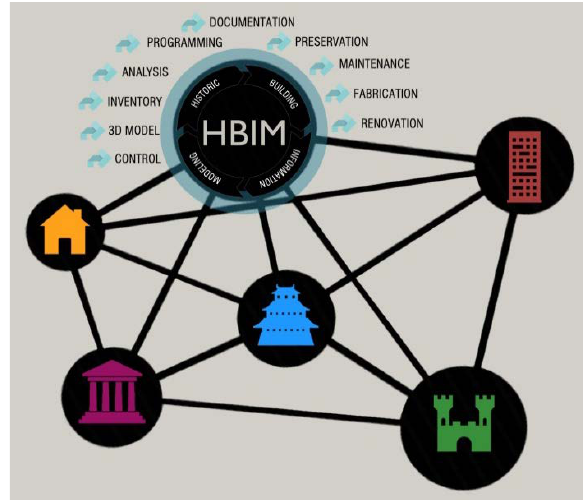
Figure 1: Structuring of